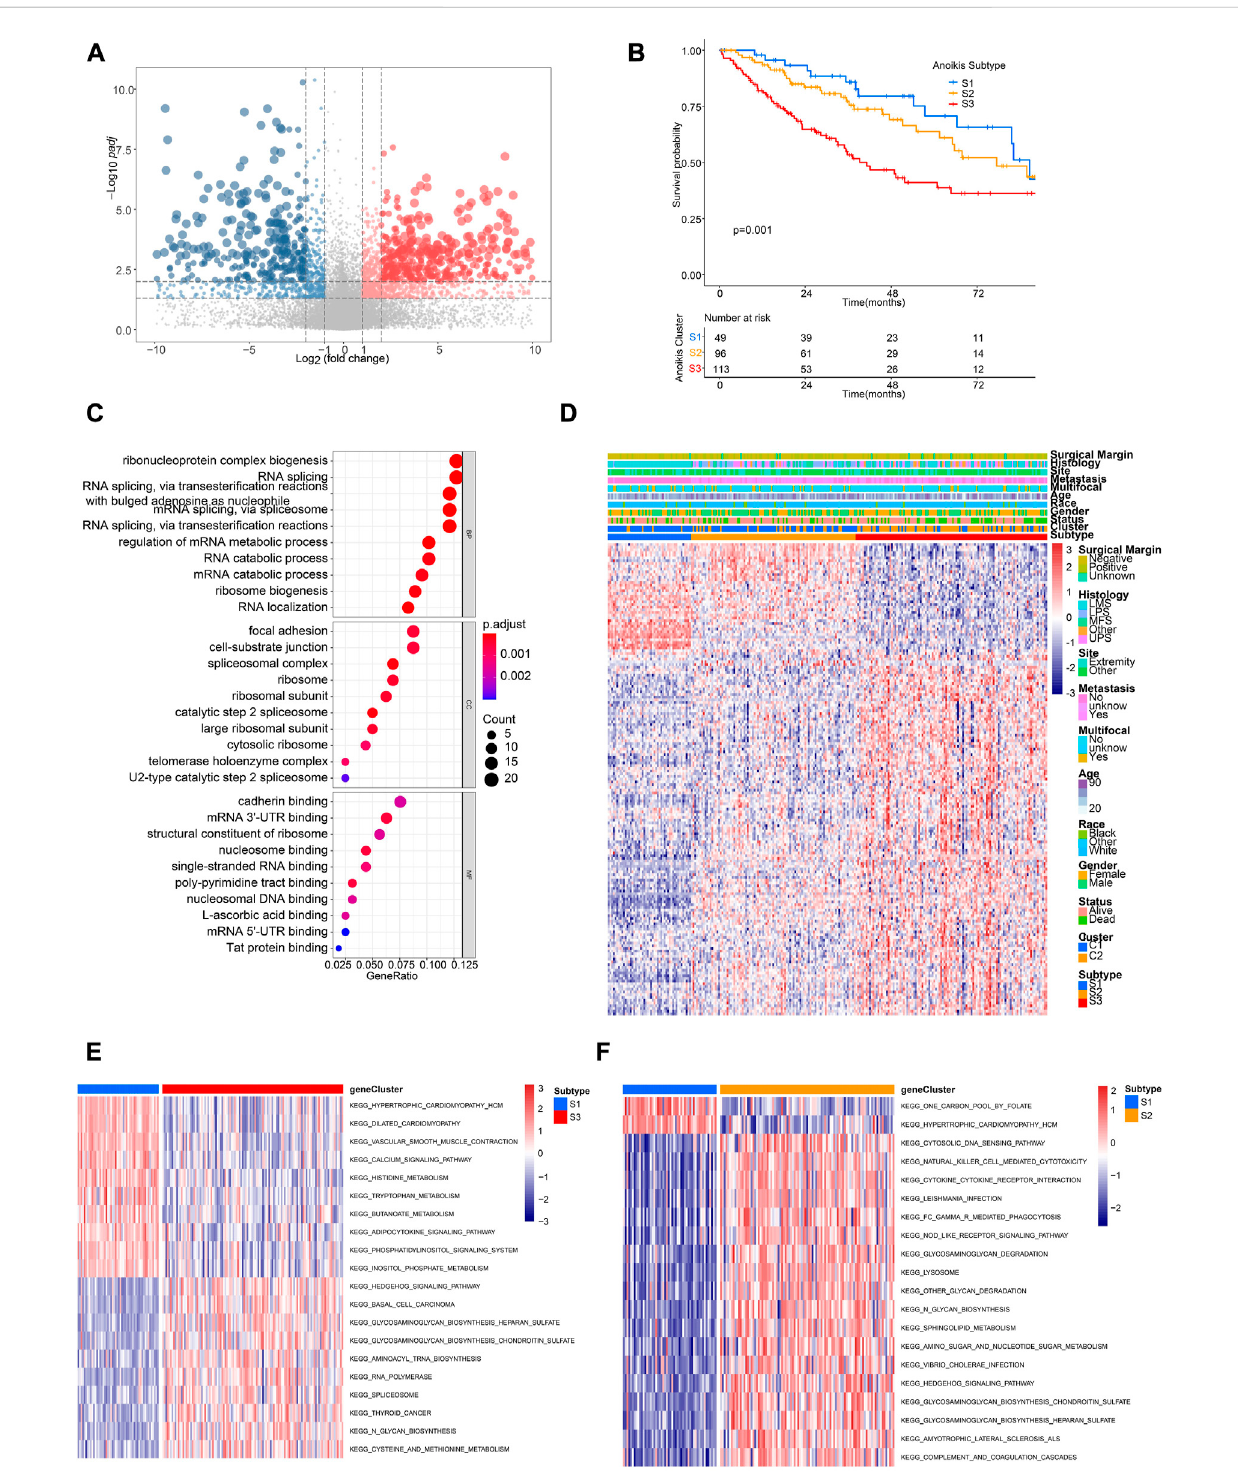
FIGURE 5 Identi fi cation of distinct Anoikis subtypes and related biological characteristics. (A) The volcano plot showing signi fi cantly differentially expressed genes (DEGs) between different Anoikis clusters (C2 versus C1). Genes signi fi cantly upregulated were marked in red, while genes signi fi cantly downregulated were marked in blue. (B) The Kaplan-Meier curve comparing the survival between different Anoikis subtypes. (C) Gene Ontology (GO) enrichment analysis of DEGs identi fi ed in the above resulted. BP, biological process; CC, cellular component; MF, molecular function. (D) The unsupervised clustering of TCGA-SARC cohort based on the ARGs-related DEGs. (E, F) The GSVA comparing pathways signi fi cantly enriched among distinct Anoikis